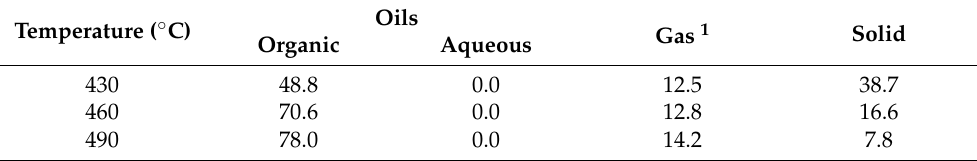
Table 9. Pyrolysis yields of PT-Film sample at different temperatures (wt.%). Temperature ( ◦